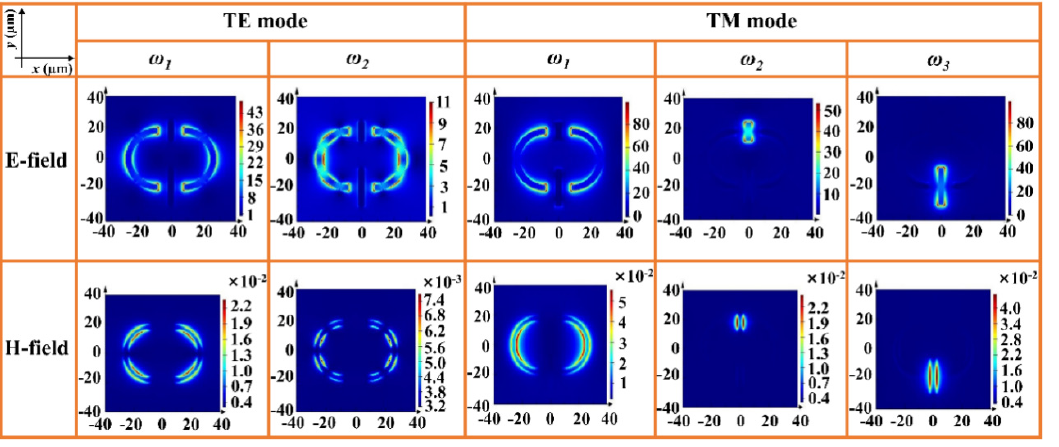
Figure 4. E- and H-field distributions of eSRR with L 1 = 24 μ m in TE and TM modes.